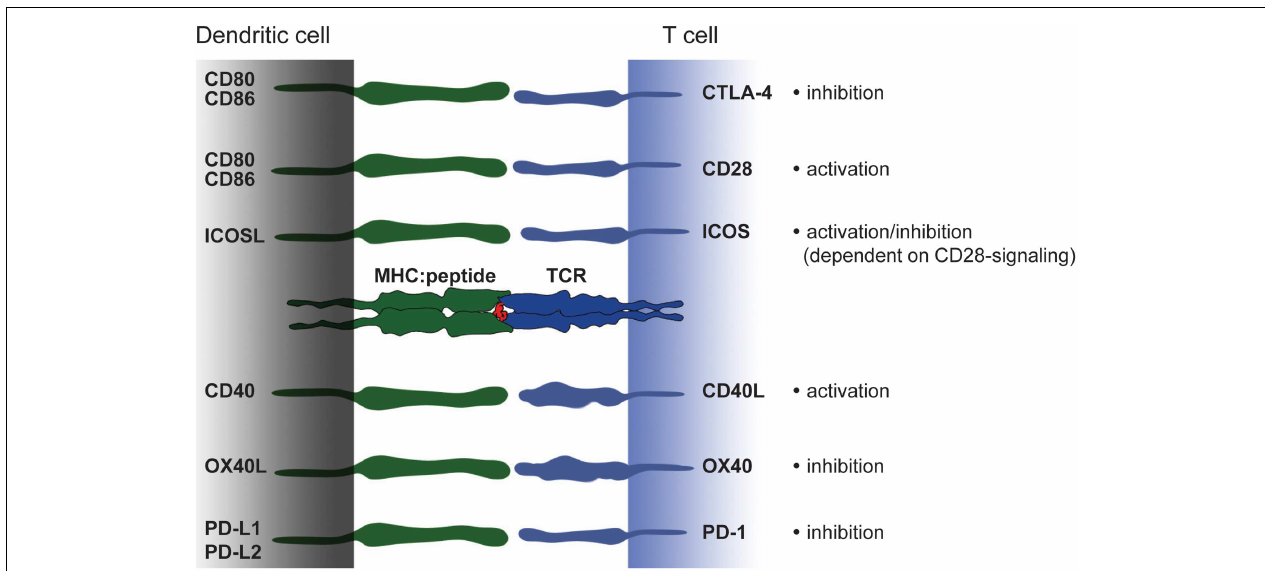
In the last decade a number of new costimulatory molecules have been identified. However, in the context of monocyte-derived DC CD80 and CD86 constitute powerful members of the costimulatory family. Strong CD80/CD86-derived signals can overcome e.g., ICOSL-mediated signaling and thereby turning a rather tolerogenic signal into an